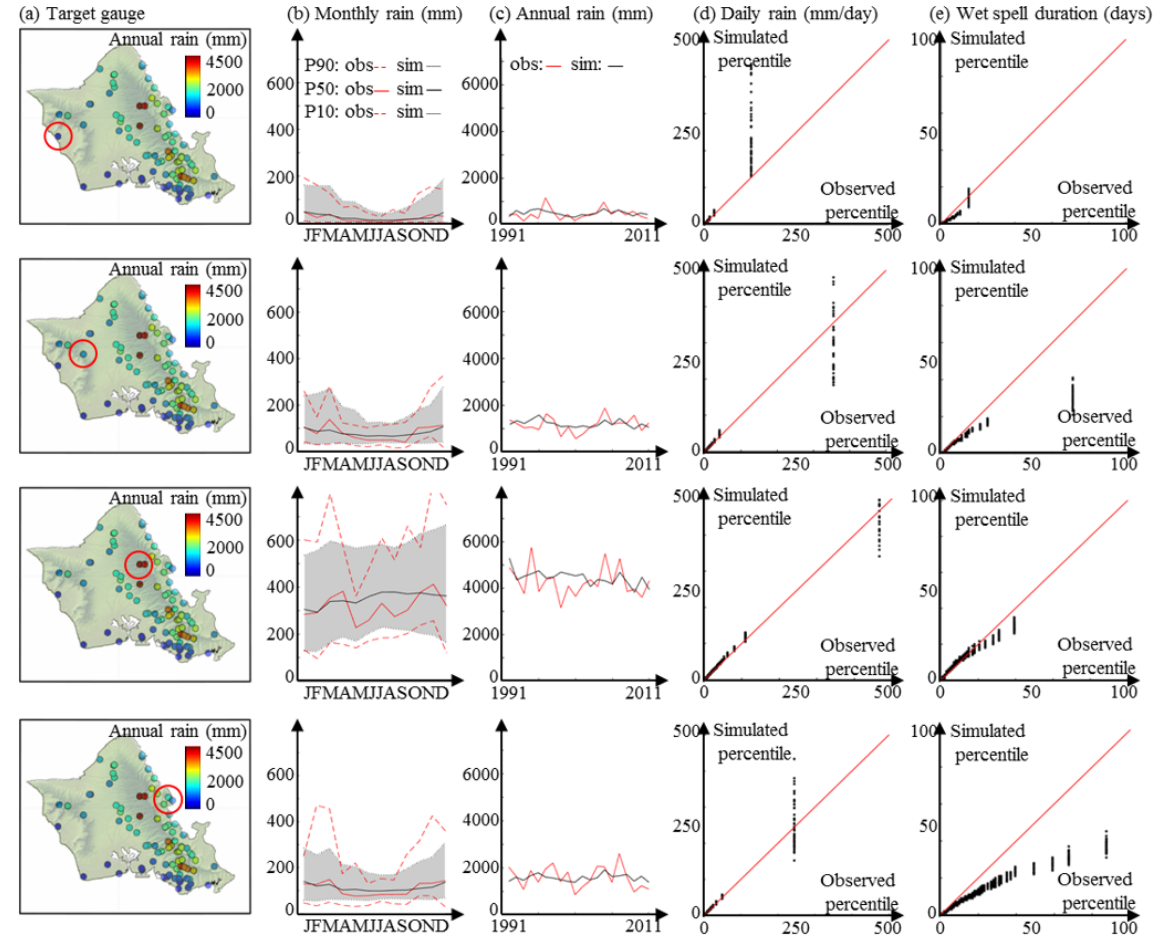
Figure 5. Ability of the model to simulate site-specific rain statistics on O‘ahu. (a) Target locations. (b) Observed (red) and simulated (black) monthly rain accumulation. Dashed lines denote quantiles 10 and 90%, and solid lines denote the quantile 50%. In the case of simulations (black), for readability, we report in the figure only the median of each quantile (10, 50, 90%) instead of 50 simulated quantiles. The grey band between the dashed black lines denotes the interval Q 10% – Q 90% derived from simulations. (c) Observed (red) and simulated (black) annual rain accumulation. In the case of simulations (black), for readability, we report in the figure only the median of the 50 simulations. (d) The q–q plot of daily rain percentiles. (e) The q–q plot of wet-spell duration percentiles. In panels (d, e) , we display q–q plots between one observation time series (abscissa) and 50 simulations (ordinates). Hence, black dots line up vertically in the q–q plots because for each percentile, 50 simulations are compared to a single